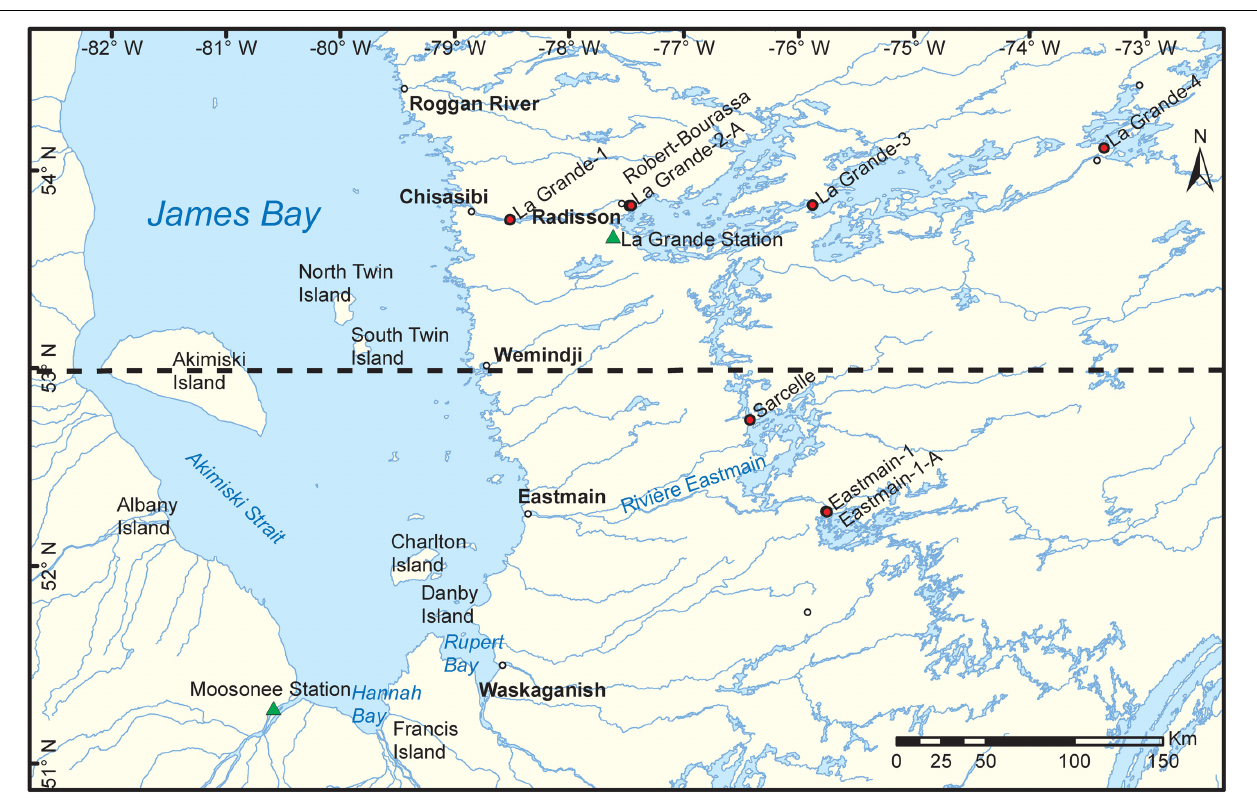
FIGURE 1 | James Bay study area. The red dots locate the generating stations constructed during the James Bay hydroelectric Project between 1979 and 2012 (Laforge-1, Laforge-2, and Brisay stations are located further upstream on La Grande river and are outside the extent of the figure). The green triangles locate the meteorological stations. The black dashed line illustrates the boundary between the “north” and the “south” area of the